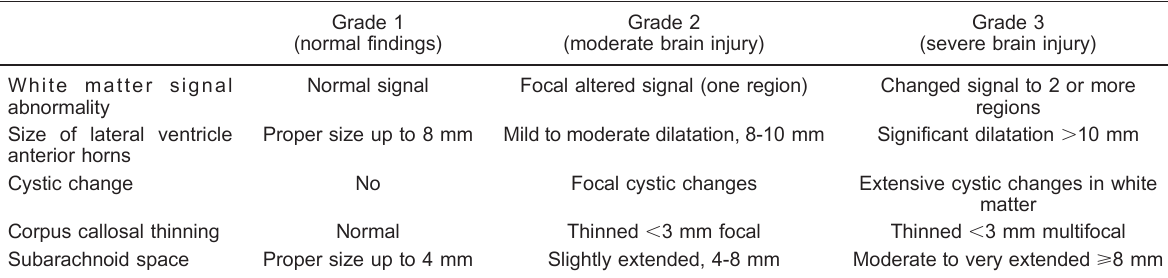
Table 1. Scoring of perinatal hypoxic-ischemic brain injury according to magnetic resonance